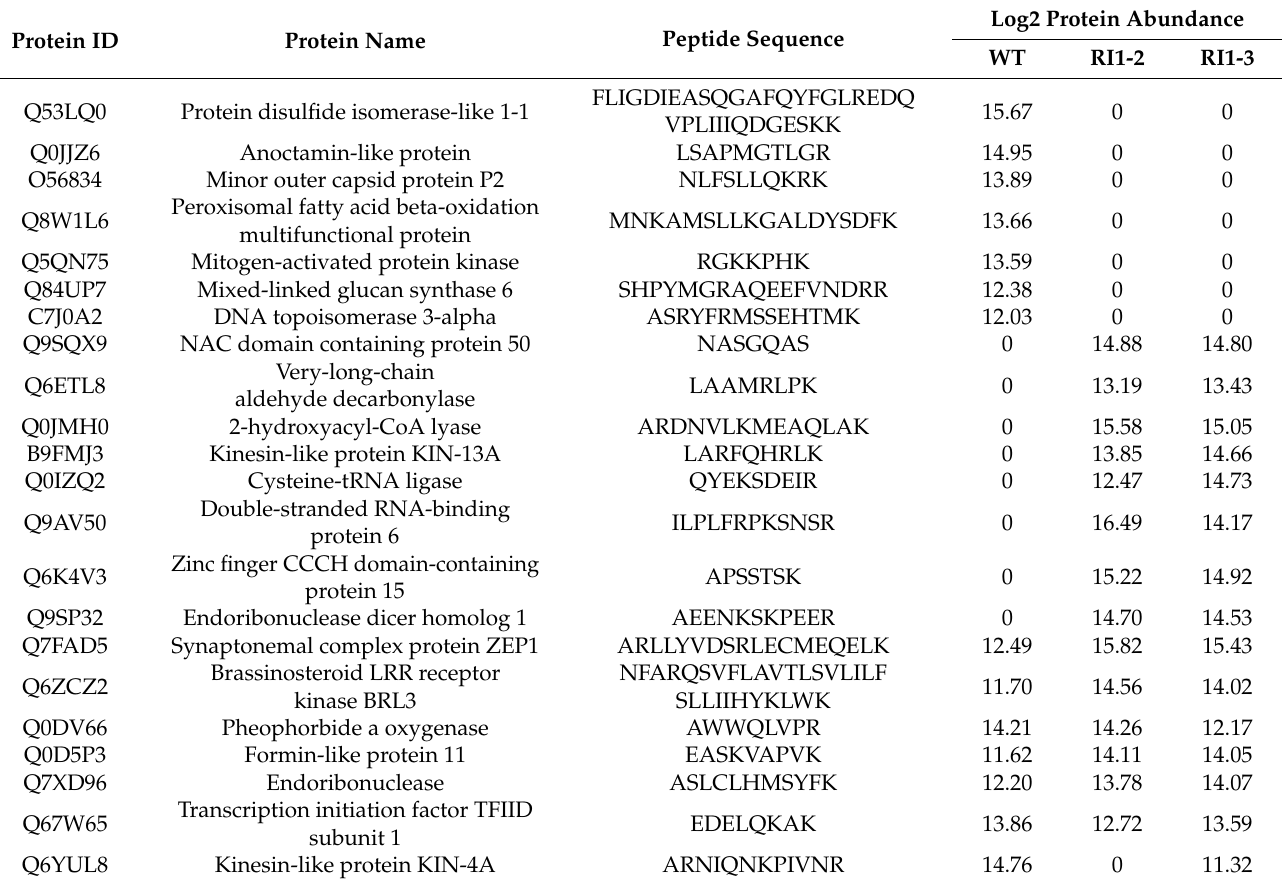
Figure 5. Venn diagram of wild type (green) proteome overlapped with RI1-2 (blue) and RI1-3 (yellow) lines. Table 3. Differentially expressed proteins in WT and OsVTC1-1 RNAi lines.